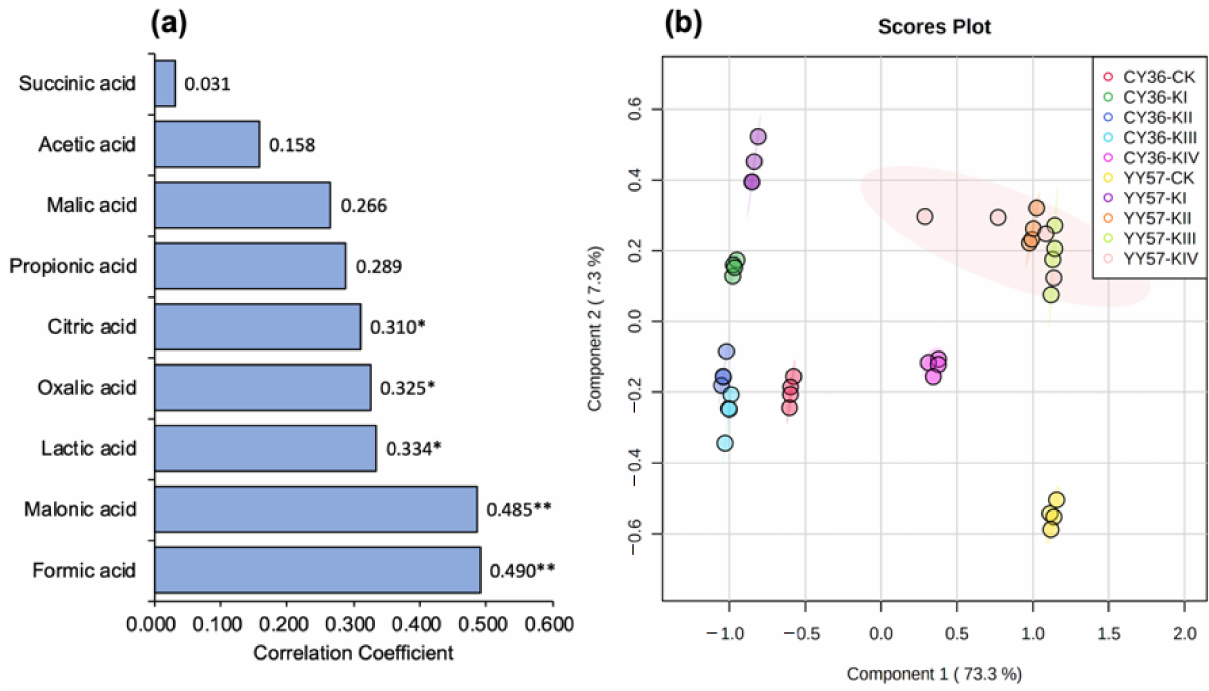
Figure 4. ( a ) The pattern search of nine organic acids in root exudates to activate AK. The numbers indicate the correlation coefficients between organic acids and the activation of AK. ** p < 0.01; * p < 0.05. ( b ) The partial least squares discriminant analysis of restoration evaluation in two rapeseed cultivars. KI, KII, KIII, and KIV indicate K supply level (K 2 SO 4 ) 0, 0.1, 1, and 10 mM under drought stress with 15% PEG, respectively, and CK indicate the control (without 15% PEG) 0.1 mM K 2 SO 4